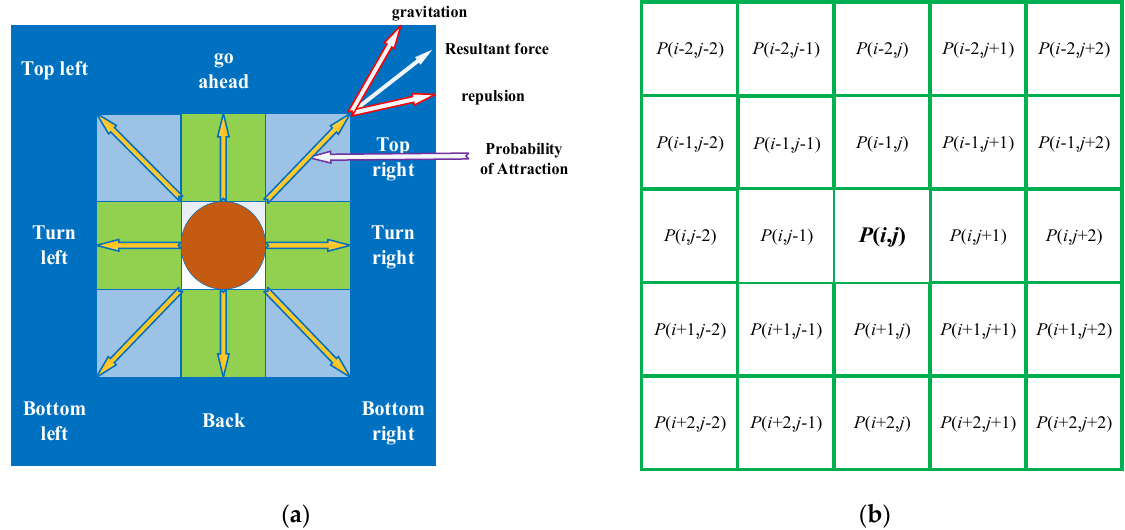
Figure 8. The cellular automata model of this system: ( a ) improved cellular automata model; and ( b ) probability diagram of the cell moving direction in the next step.